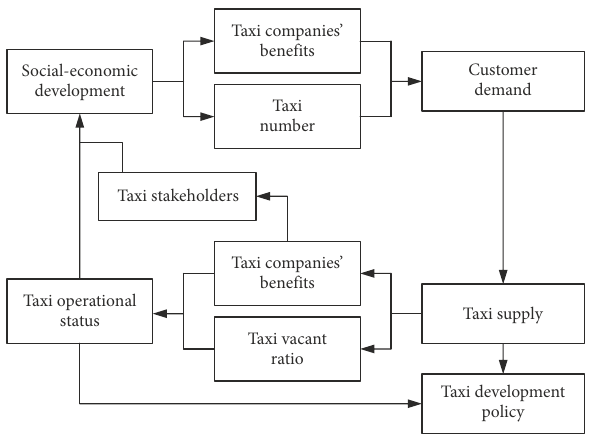
Figure 2. The module relationship of the SD